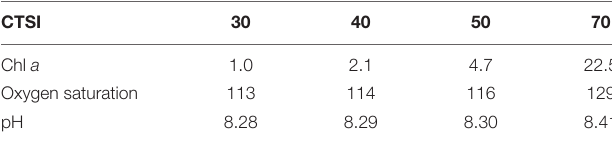
TABLE 2 | The corresponding values of chlorophyll a (Chl a ), oxygen saturation (%), and pH to the Carlson trophic state index (CTSI) based on the water quality data obtained from Dapeng Bay